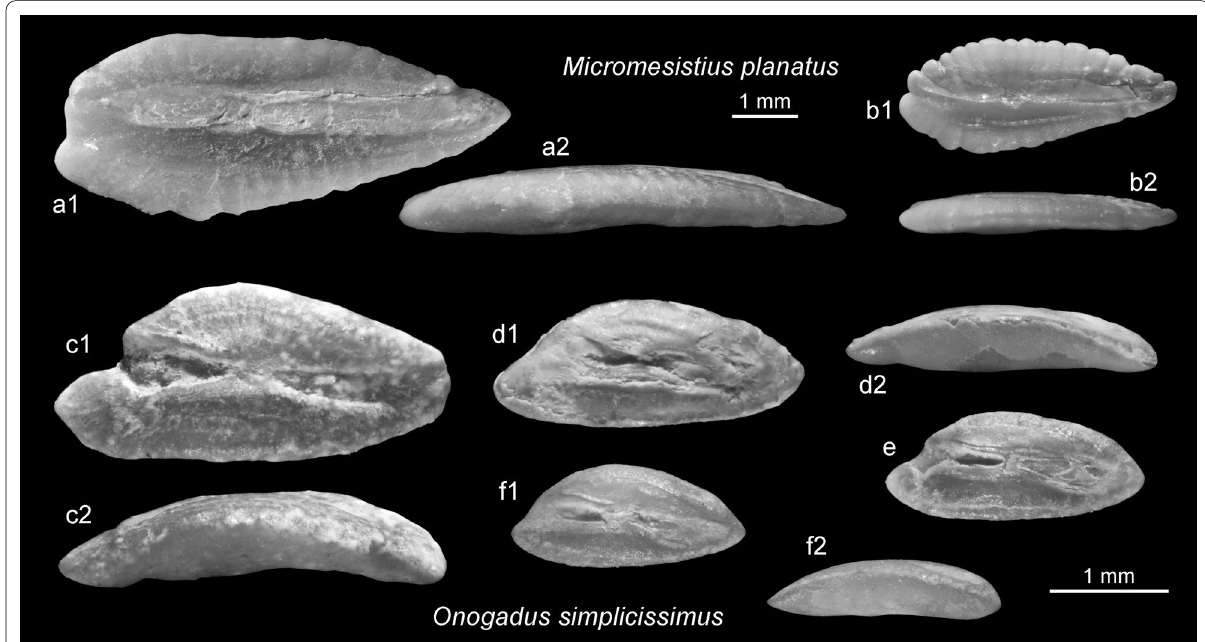
Fig. 3 Otoliths of Gadiformes: a , b Micromesistius planatus (Bassoli & Schubert, 1906), Mlyntsi, a NMNHU-P PI 2568 and b NMB P1218. c – f Onogadus simplicissimus (Schubert, 1906), c (reversed), d , f Shydlivshchyna, NMB P1220, e Mlyntsi, NMNHU-P PI